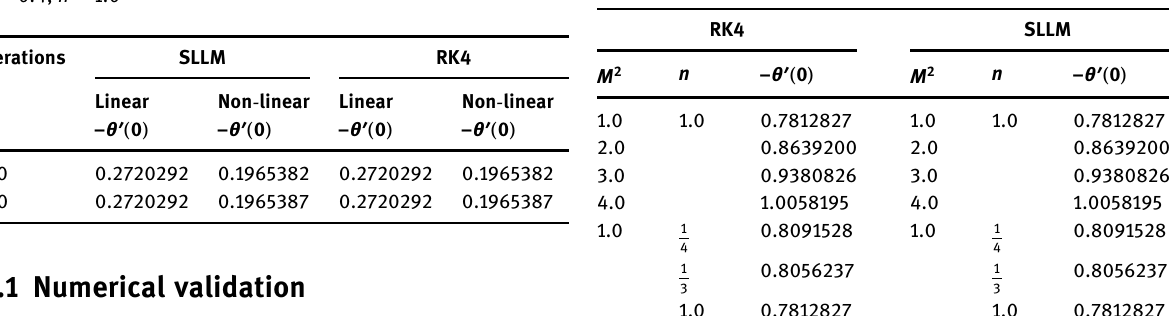
Table 3: Temperature gradient (